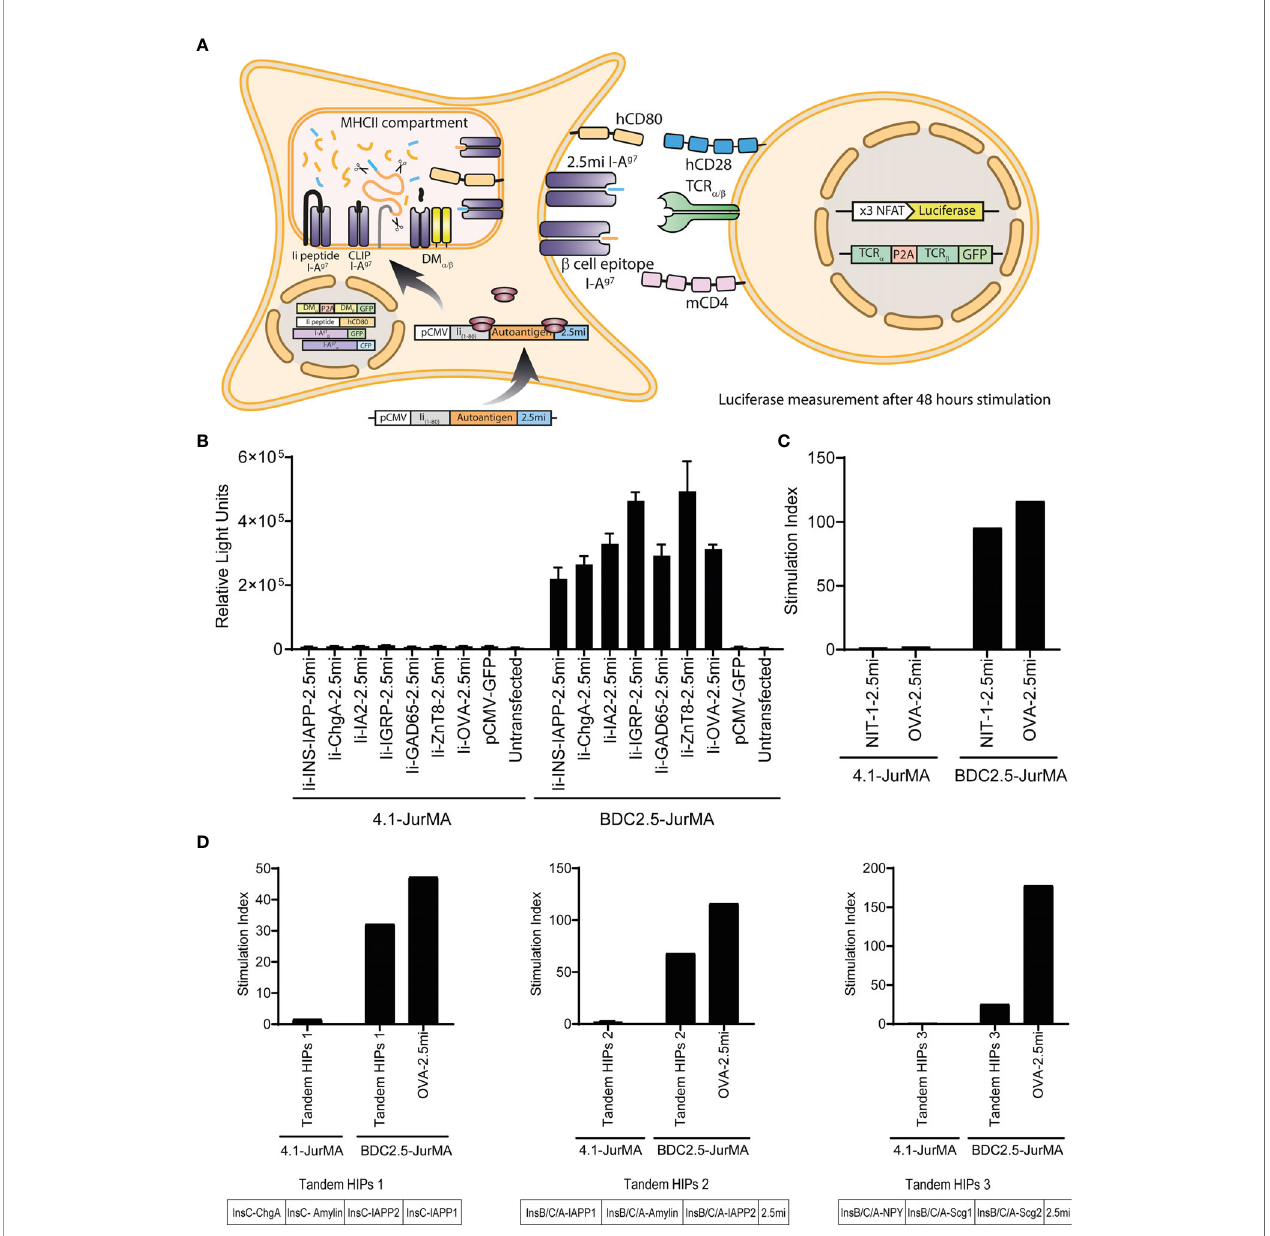
FIGURE 1 | The 4.1-TCR does not recognize known T1D-associated autoantigens. (A) Cartoon depicting the experimental approach used to probe the agonistic properties of known T1D-associated autoantigens and peptides on 4.1-TCR-expressing cells. HEK-293T cells expressing transgenic I-A d a , I-A g7 b , H2-DM a / b , and invariant chain (CD74 or Ii) (HEK-293T-I-A g7 ) were transiently transfected with CMV promoter-driven expression vectors encoding fusions of the fi rst 80 amino acids of murine invariant chain 1-80 (Ii 1-80 ) with speci fi c autoantigens and a BDC2.5mi mimotope-coding sequence as an internal positive control (pCMV-Ii-autoantigen- 2.5mi). These autoantigen-expressing arti fi cial APCs were then co-cultured for 48 h with a JurMA cell-based responder T-cell line expressing mCD4, an NFAT-driven luciferase reporter, and the alpha and beta chains of the 4.1-TCR or the BDC2.5-TCR (as a positive control, recognizing the BDC2.5mi mimotope in the context of I-A g7 ), to measure luciferase activity. (B) The different autoantigen-2.5mi fusion-encoding plasmids readily triggered luciferase activity in BDC2.5-JurMA cells but not in 4.1-JurMA cells. (C) HEK-293-I-A g7 cells stably transfected with an expression vector encoding, in tandem, I-A g7 -binding peptides eluted from CIITA-transgenic NIT-1 cells plus C-terminal BDC2.5mi peptide (NIT-1-2.5mi) also failed to trigger 4.1- but not BDC2.5-JurMA cell activation. (D) HEK-293-I-A g7 cells expressing potential HIPs cloned in tandem in three different expression vectors (Tandem-HIPs 1, 2 and 3, see also Supplementary Figure S1 ) triggered luciferase activity in BDC2.5-JurMA cells (reactive to its target HIP: LQTLAL-WSRMD) to levels similar to those obtained with arti fi cial APCs transfected with a plasmid encoding an OVA-BDC2.5mi epitope fusion. The potential of the 4.1-JurMA cell line to induce luciferase expression upon TCR crosslinking was previously established with plate- bound anti-CD3 antibodies (data not shown). Stimulation indexes were calculated using the luciferase activity of every condition relative to that obtained using non- transfected arti fi cial APCs within the same